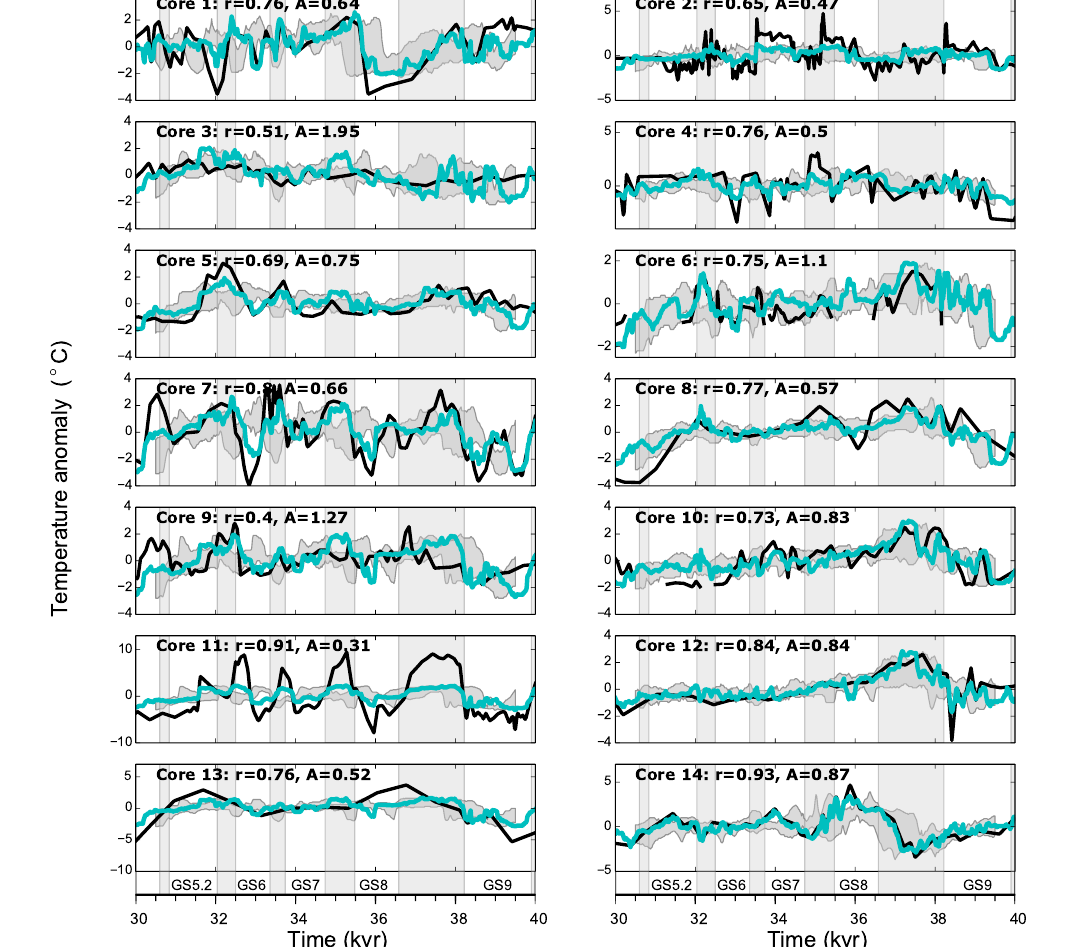
Figure 6. Surrogate time series (blue) and proxy time series (black) for all 14 core locations. All time series are plotted as anomalies from the mean value of the respective time series. The filtered, JAS-averaged SSTs from HadCM3 are used. Core numbers correspond to those shown in Fig. 1, and r is the correlation coefficient of the time series at each location. A is the ratio between the standard deviation of the two shown time series, A = σ ( c i ) /σ ( T p ), where c i and T p are the surrogate and proxy reconstructions at location i , respectively. The grey i i shading around the surrogate time series is the 90% confidence interval produced by shifting each proxy record individually by ± 500 years (Sect. 2.2 for details). The vertical bars represent interstadial conditions in Greenland as defined by Rasmussen et al. (2014), and the GSs are named in the lowermost